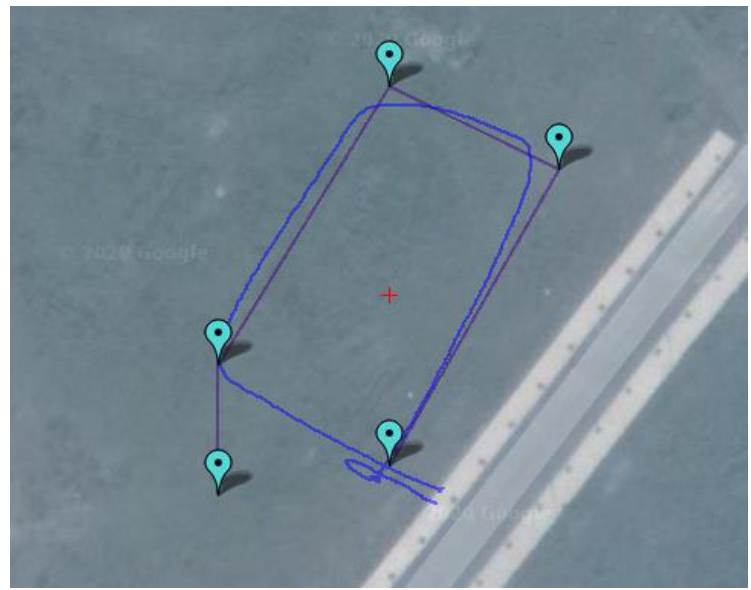
Figure 20. The difference between desired and real trajectories (pink line — desired trajectory, blue line — real trajectory).